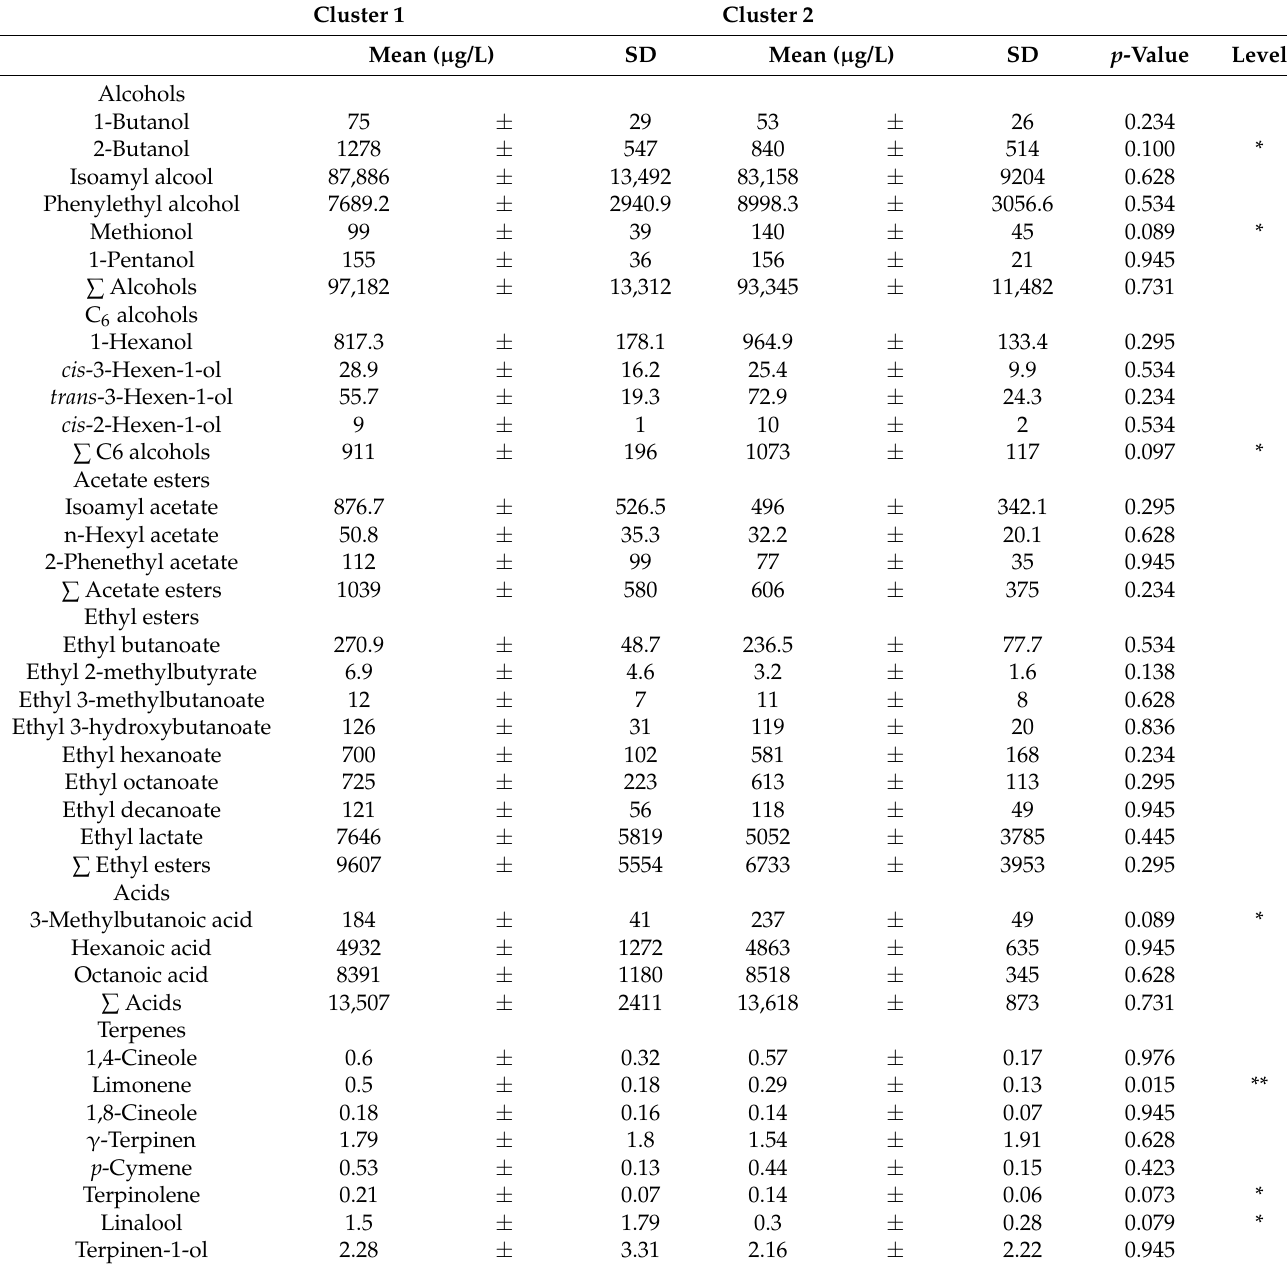
Table 3. Concentration ( µ g/L) of free volatile compounds in Cluster 1 and Cluster 2 wine samples. Odor threshold,